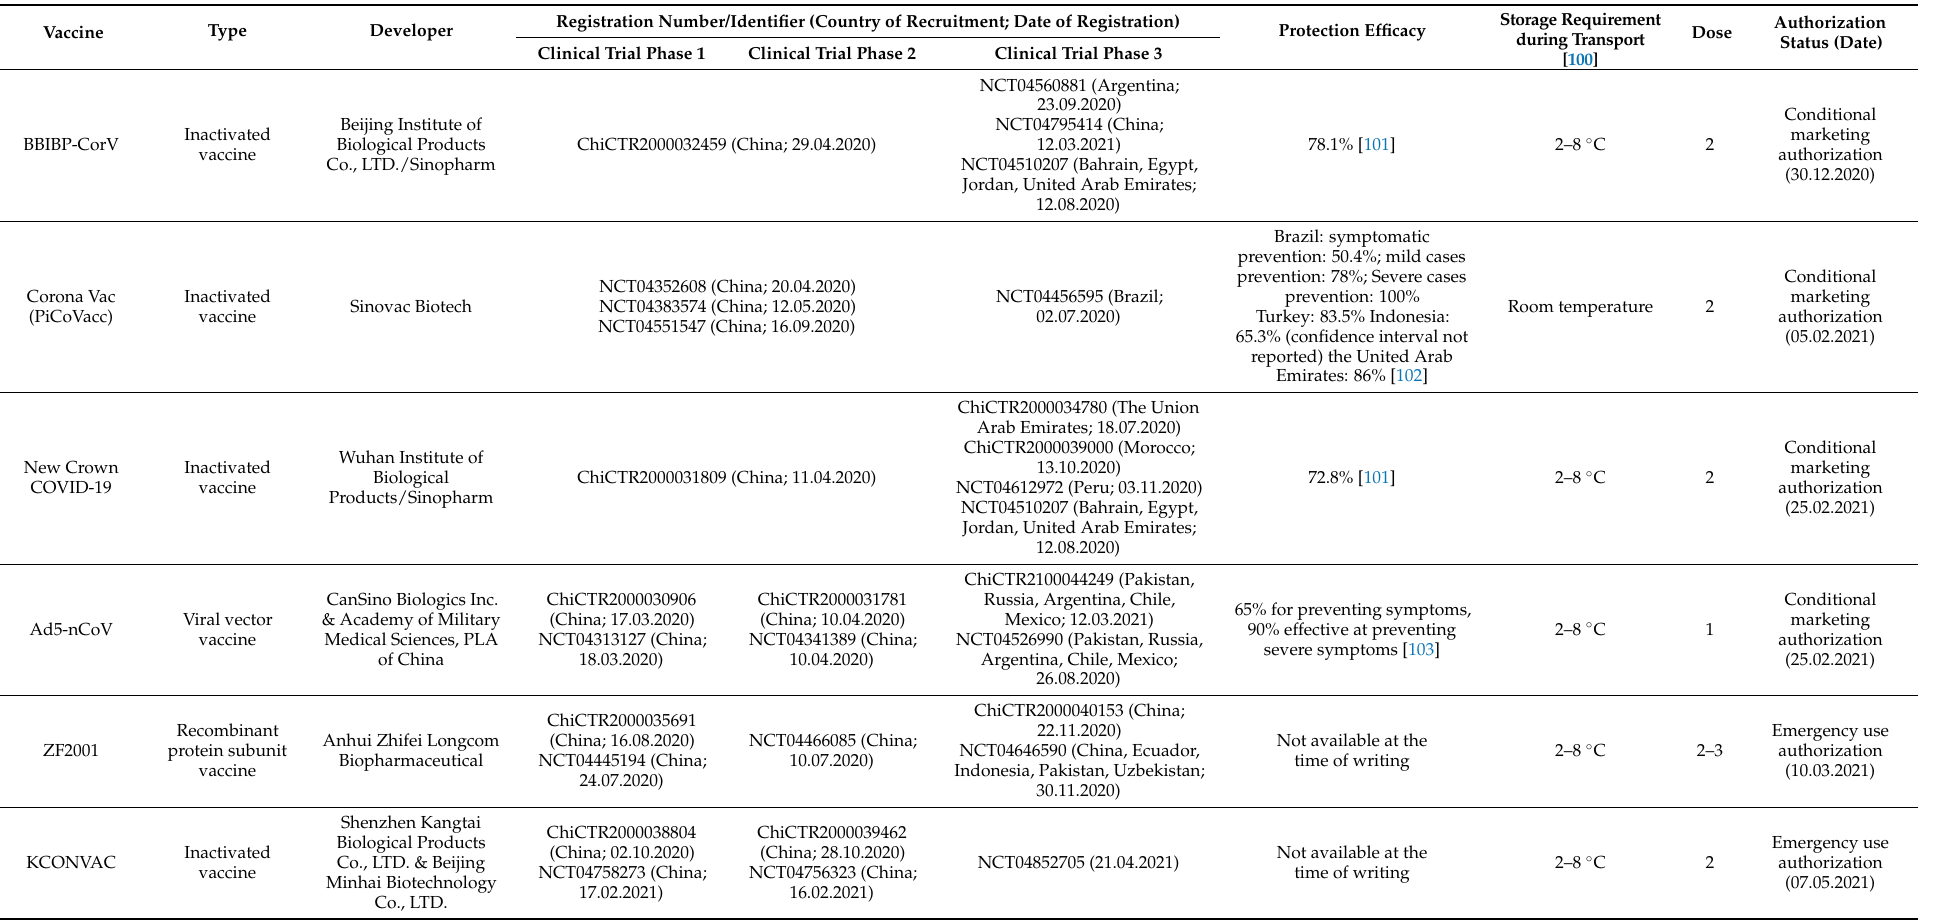
Table 2. Current available vaccines in China by 21 May